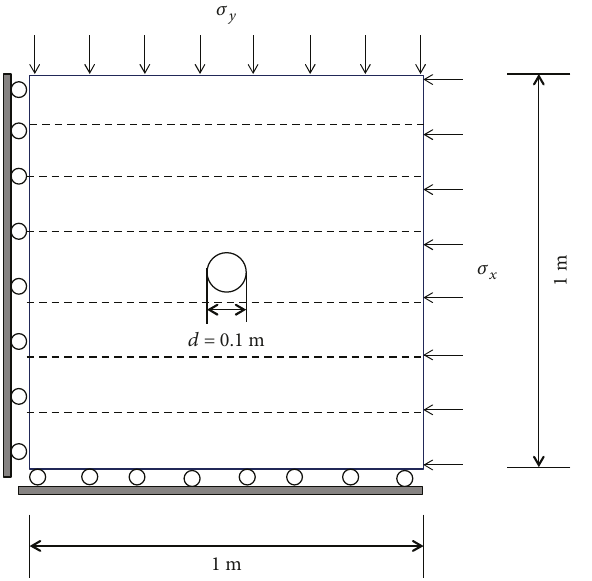
Figure 7: Change of permeation depth with permeability.